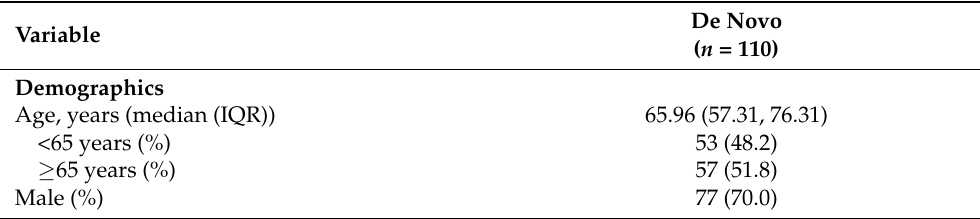
Table 1. Baseline and demographic characteristics of de novo metastatic melanoma patients in Alberta, Canada (diagnosed between